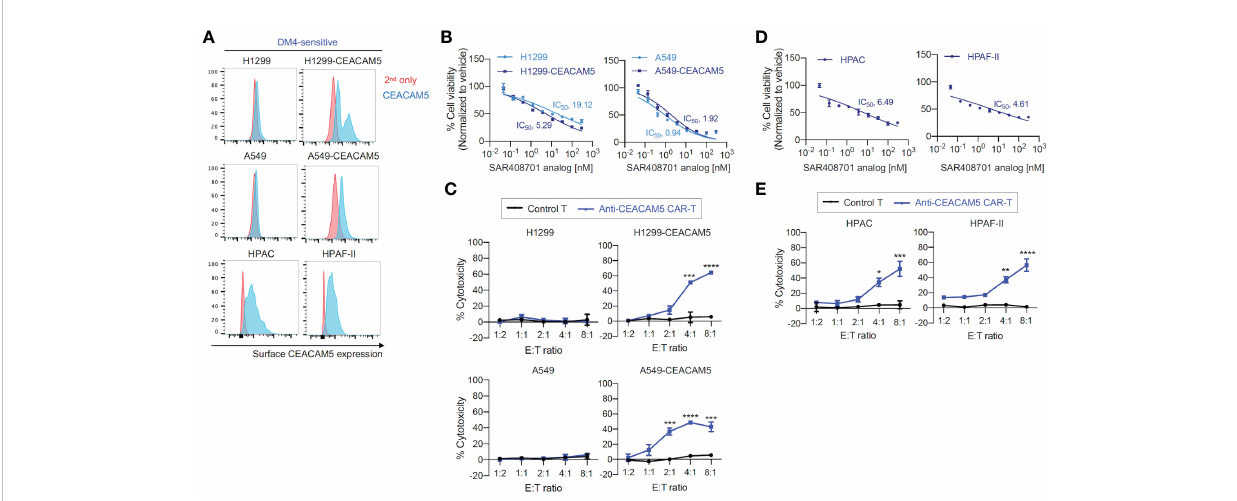
FIGURE 2 in vitro cell killing activities of the ADC SAR408701 analog and CAR-T cells targeting CEACAM5 in DM4 S cells. (A) Cell surface CEACAM5 expression levels in DM4 S NSCLCs (H1299, H1299-CEACAM5, A549, and A549-CEACAM5 cells) and PDACs (HPAC and HPAF-II cells). (B, D) Cell killing activities with ADC SAR408701 analog against DM4 S NSCLCs (H1299, H1299-CEACAM5, and A549, A549-CEACAM5 cells) (B) and DM4 S PDACs (HPAC, and HPAF-II cells) (D) . Normalized % cell viability (ATP level) was calculated by normalizing luminescence values using vehicle (buffer)-treated respective cells. The IC 50 were then determined by nonlinear regression plot of percent speci fi c cytotoxicity versus Log10 concentration of ADC SAR408701 analog using GraphPad Prism software. (C, E) Cytotoxic activities (%) of anti-CEACAM5 CAR-T cells against DM4 S NSCLCs (C) and PDACs (E) . Signi fi cance was tested using one-way ANOVA, followed by the tukey ’ s multiple post hoc test. ****, P <0.0001; ***, P <0.001; **, P <0.01; *, P <0.05; versus control T at each E:T ratio. (B – E) Results are shown as the mean ±SD for representative data from three independent